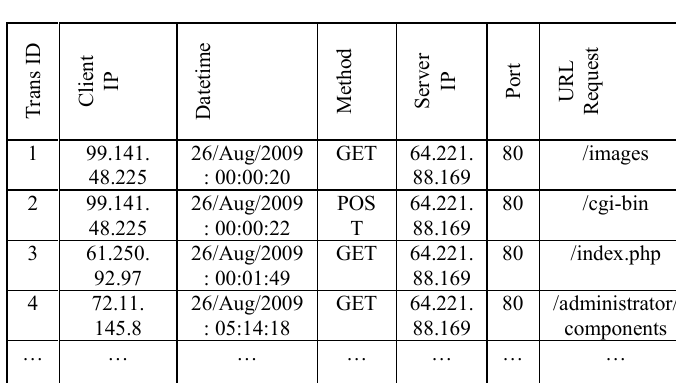
Table 1. Web User's Request Interprets